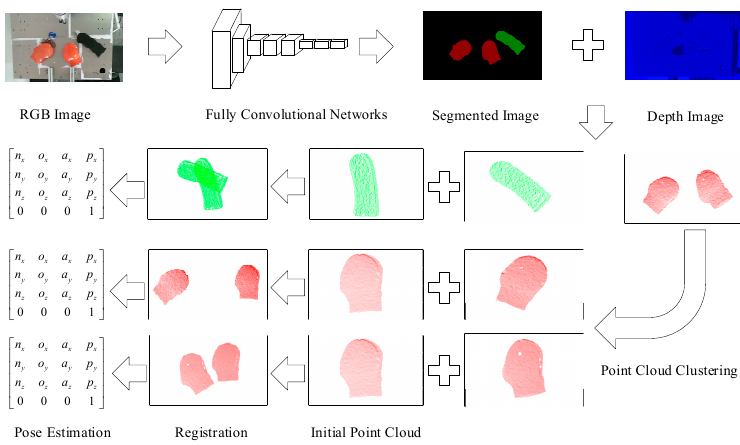
Figure 2. Pose estimation scheme. We first use an RGB-D (color and depth) sensor to capture the RGB and depth images of scattered workpieces, then the pretrained modified Fully Convolutional